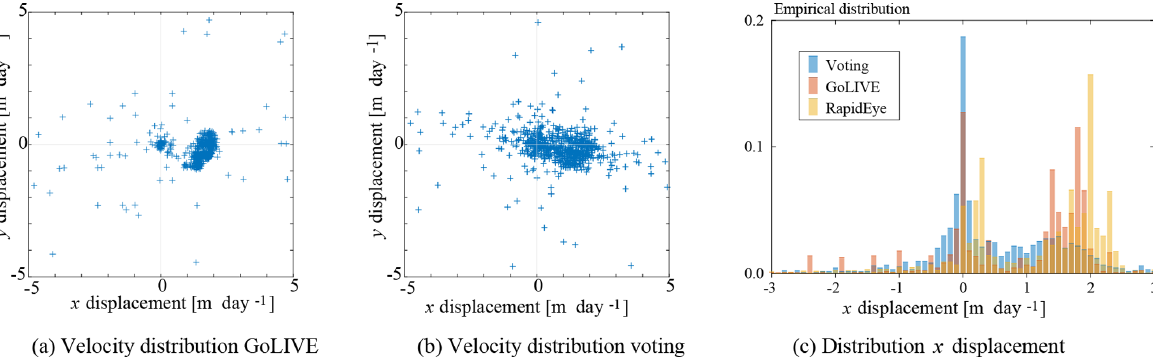
Figure 10. Panels (a) and (b) show the distribution of velocities for a section of Klutlan Glacier; their map views are shown in Fig. 9. In panel (c) the same x -component data as in Fig. 9 are shown, but now the distributions are